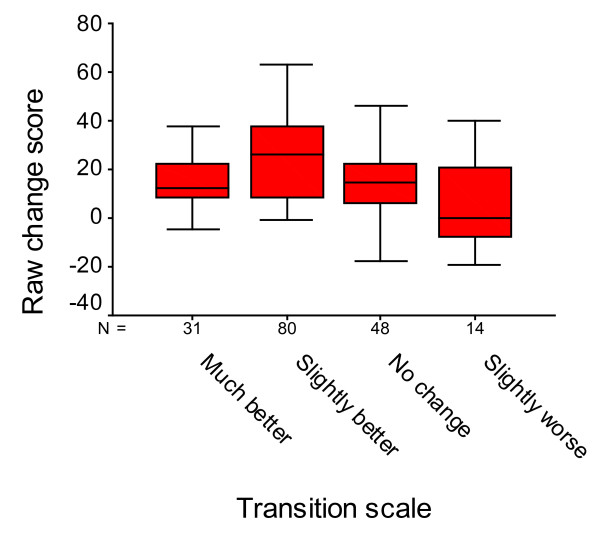
Box plot of the WOMAC raw change (6-week follow up vs. baseline) within transition scale at endpoint. Central line, median; boxes, 25th to 75th percentiles; whiskers, 95% confidence intervals.